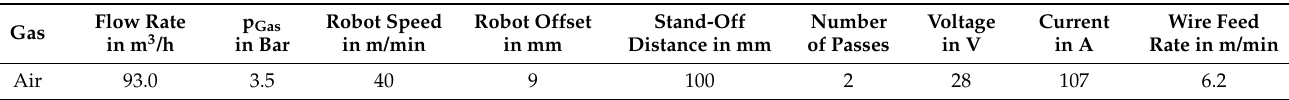
Table 2. Thermal spray